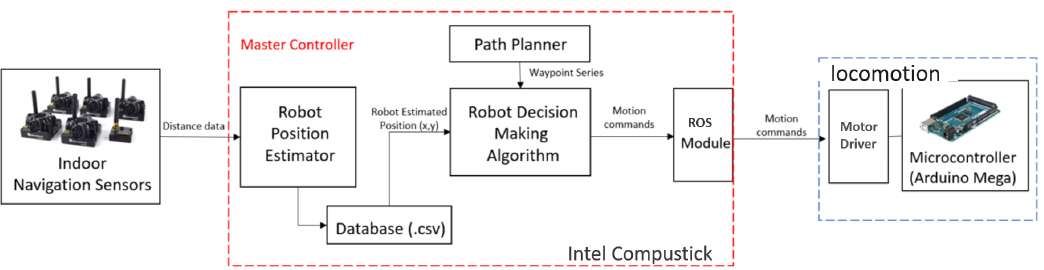
Figure 13. Flowchart of the robot motion planner for